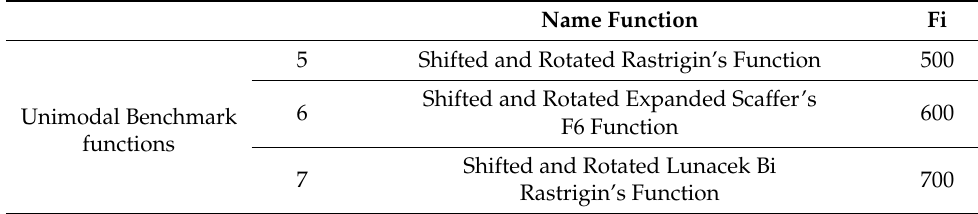
Table 3. Mathematical complex function of